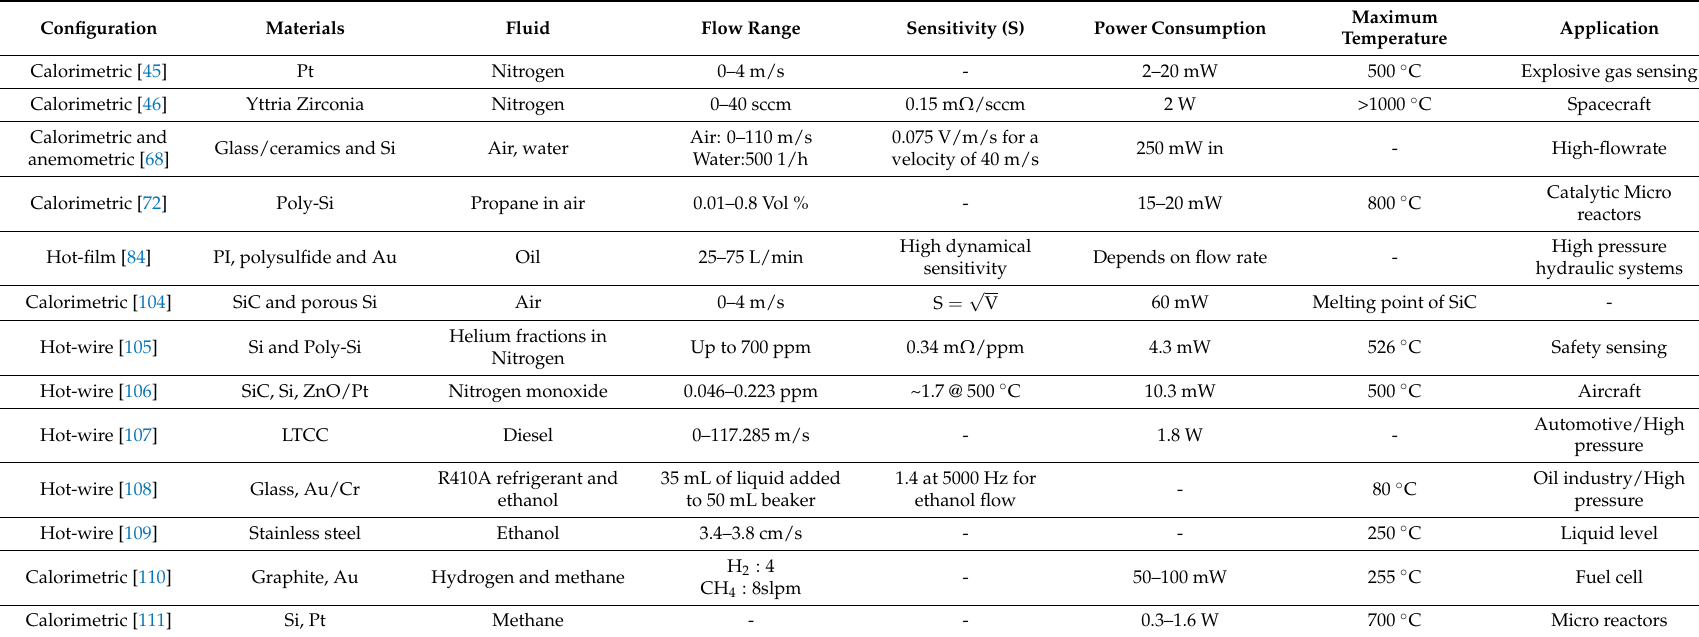
Table 5. Typical research results of thermoresistive flow